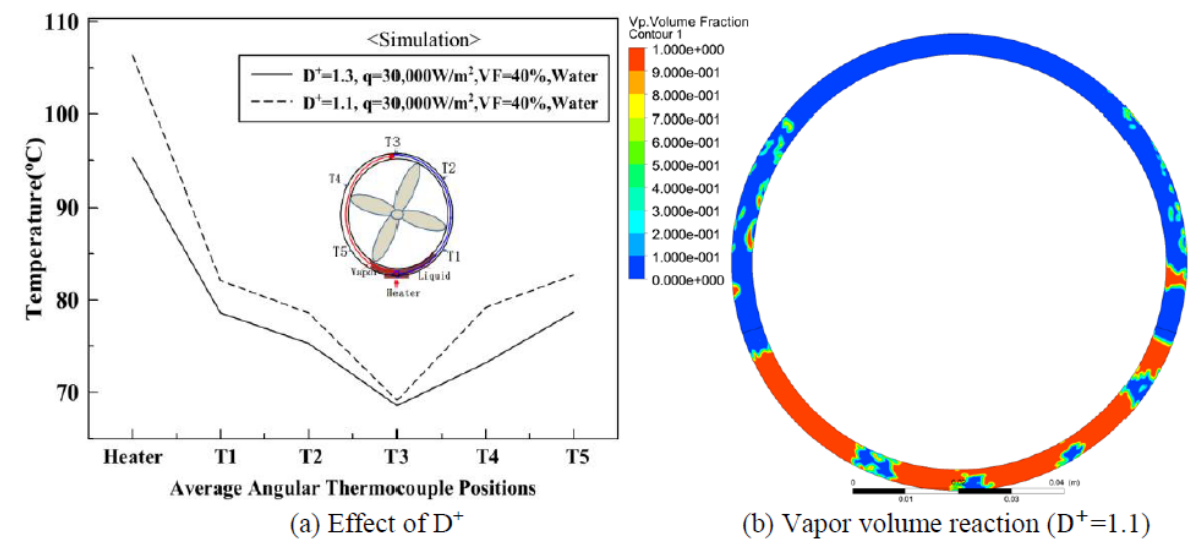
Figure 12. Comparison of effect of different D + values.